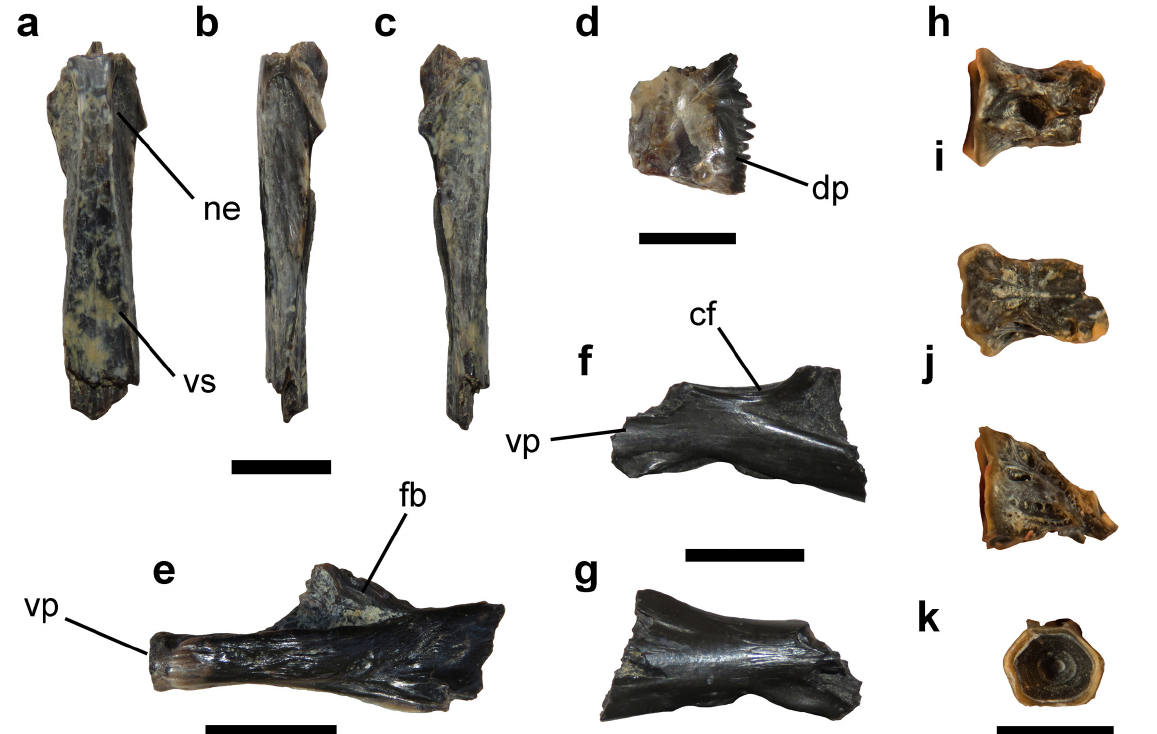
Figure 4. Percichthyidae genus and species indeterminate. a-c, parasphenoid (LIEB-PV 8002) in a, ventral; b, left lateral; and c, dorsal views. d, left preopercular (LIEB-PV 8002) in lateral view. e, ceratohyal (LIEB-PV 8002) in lateral view. f-g, incomplete ceratohyal (LIEB-PV 8005) in e, lateral; and f, medial views. References: cf, ceratohyal foramen; dp, dentate posterior margin; fb, flange of bone; ne, parasphenoid neck; vp, ventral process; vs, ventral surface. Scale bar: a-c, e, 1 cm; d, h-k, 0.5